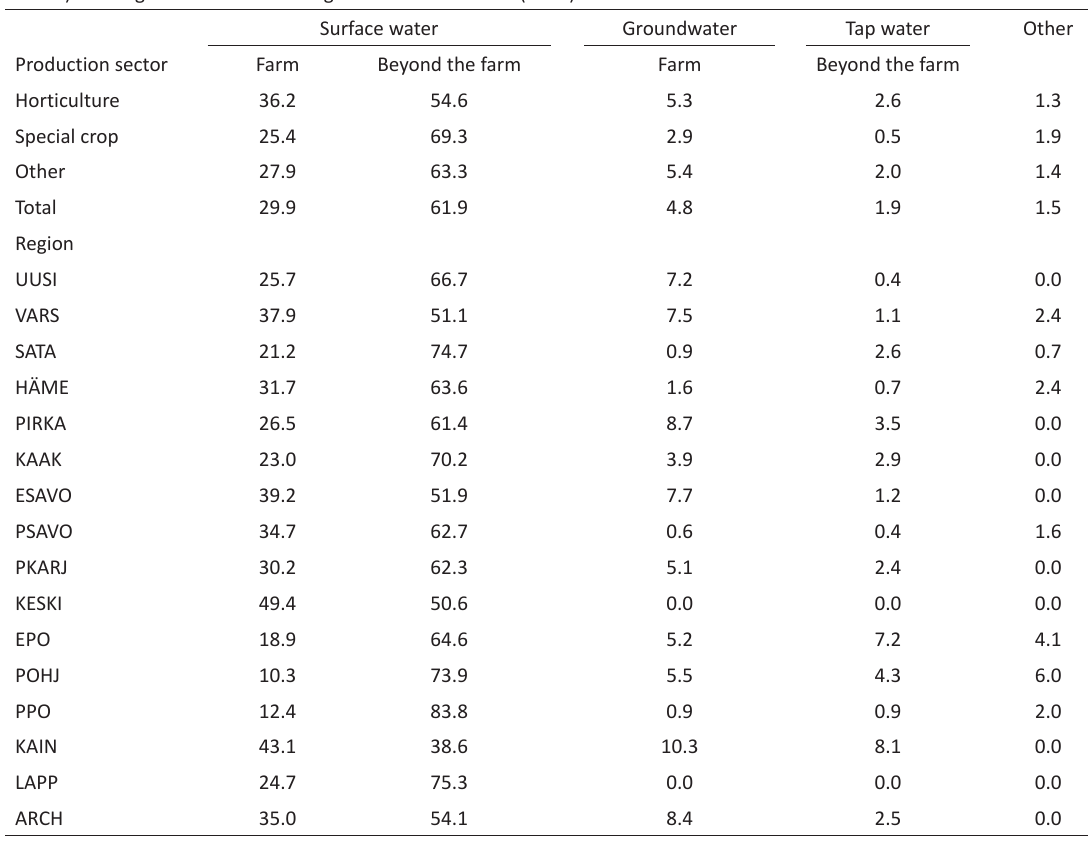
Table 5. Origin of irrigation water (%) in 2010 according production sector and regions (surface water from the farm or from a waterway that extends beyond the farm, groundwater from the farm, tap water from outside the farm and other source of water). See regions in Table 2 and Figure 1. Data from Tike